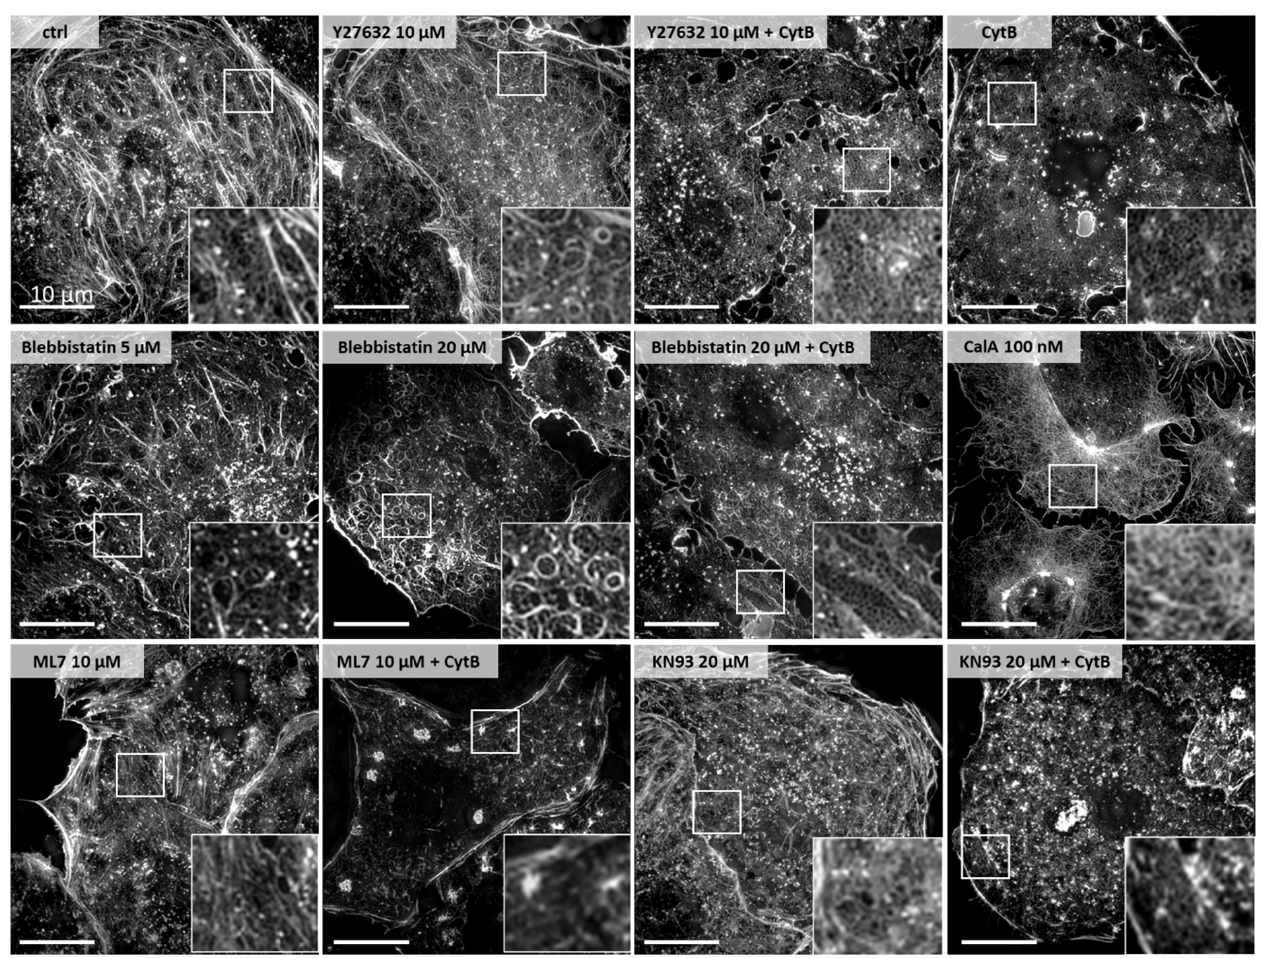
Figure 3. The SIM projection images (phalloidin-Atto647N actin staining) of representative LSEC treated with the inhibitors. The selected area (white square) on LSEC periphery was digitally magnified (inset). All images size: 40.96 µm × 40.96 µm, insets: 6.2 µm × 6.2 µm.